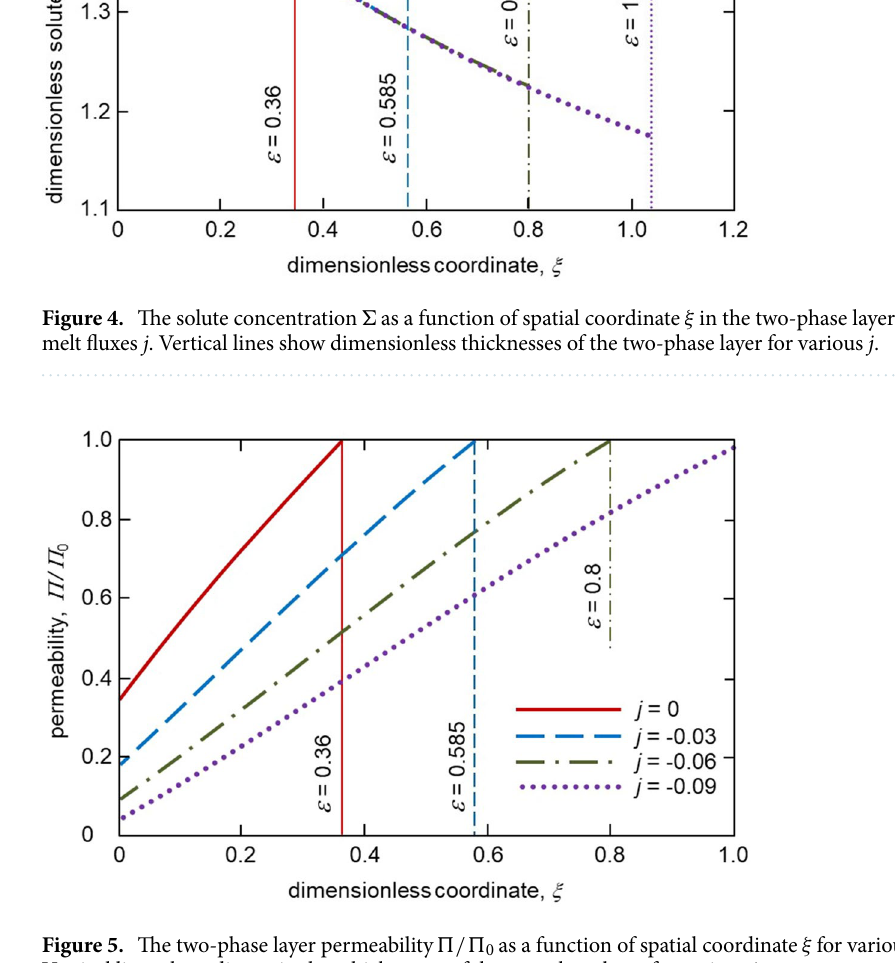
Figure 5. The two-phase layer permeability �/� 0 as a function of spatial coordinate ξ for various melt fluxes j . Vertical lines show dimensionless thicknesses of the two-phase layer for various j